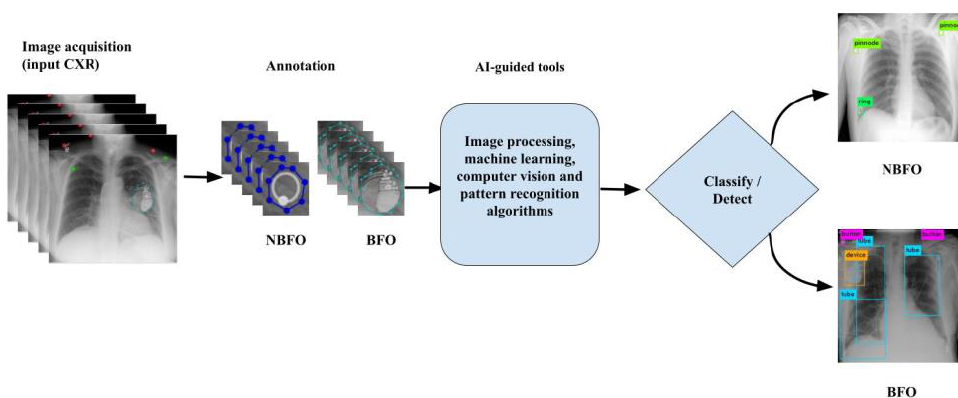
Figure 3. Typical workflow of the AI-guided tools for foreign object (NBFO and BFO) classifica- tion/detection.